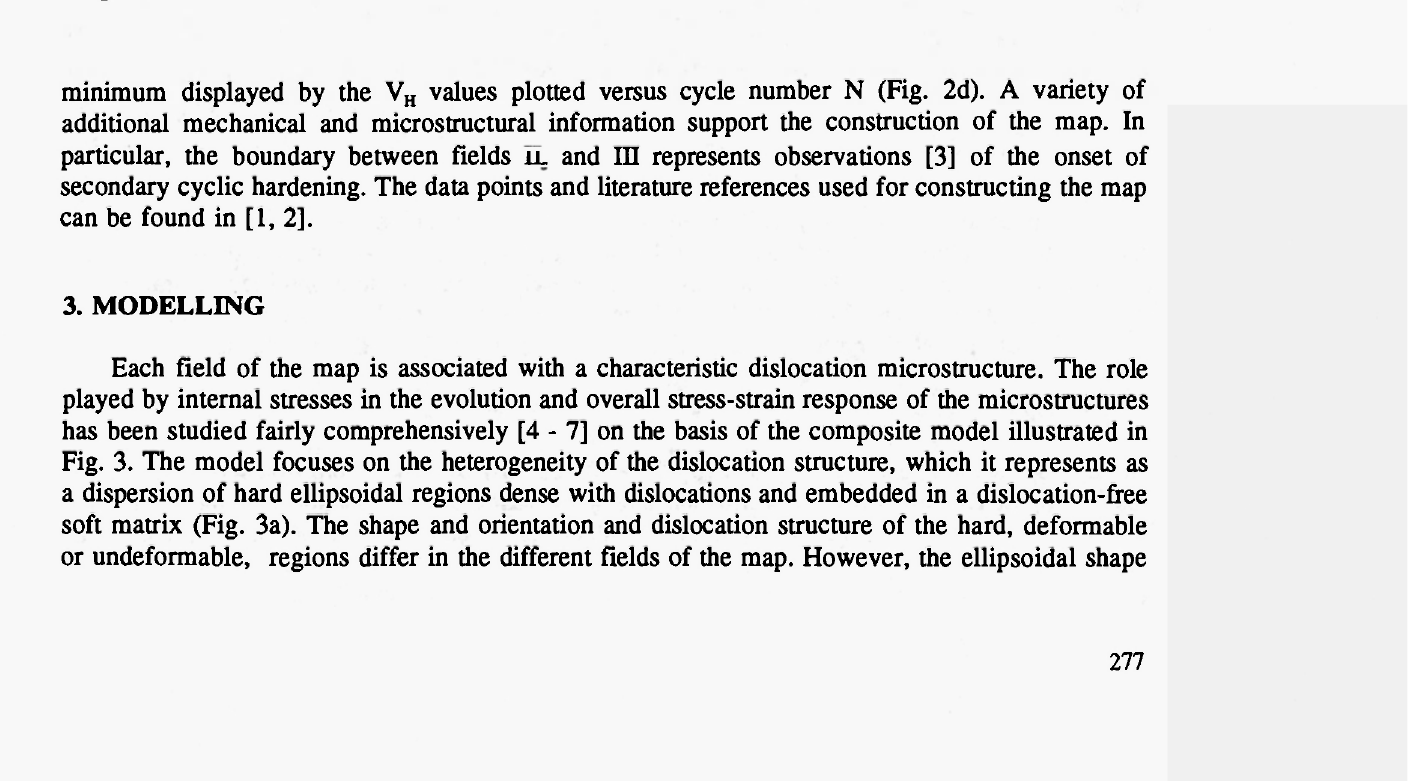
Fig. 2. The main information on tensile and cyclic stress-strain behaviour used for constructing the fatigue mechanism